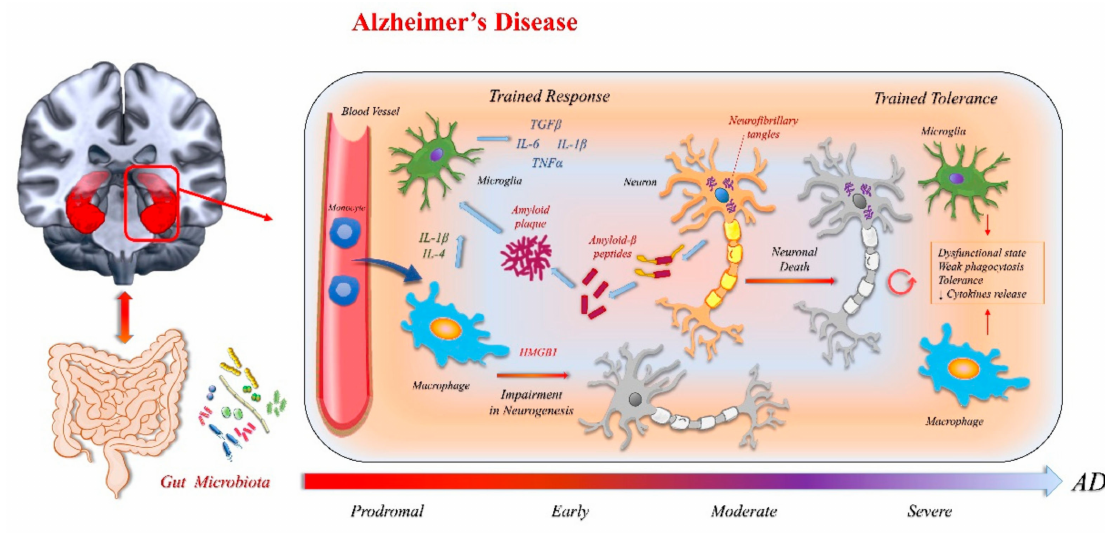
Figure 2. Immunological mechanisms associated with the pathogenesis of Alzheimer’s